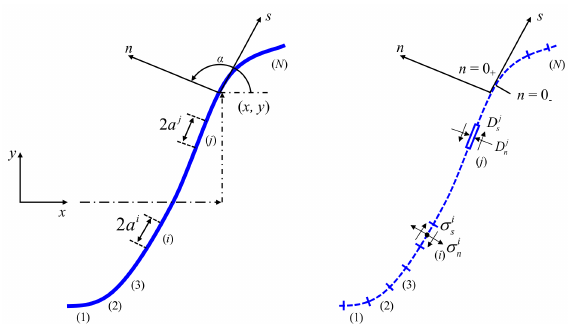
Figure 1. A curved fracture discretized by N elemental displacement